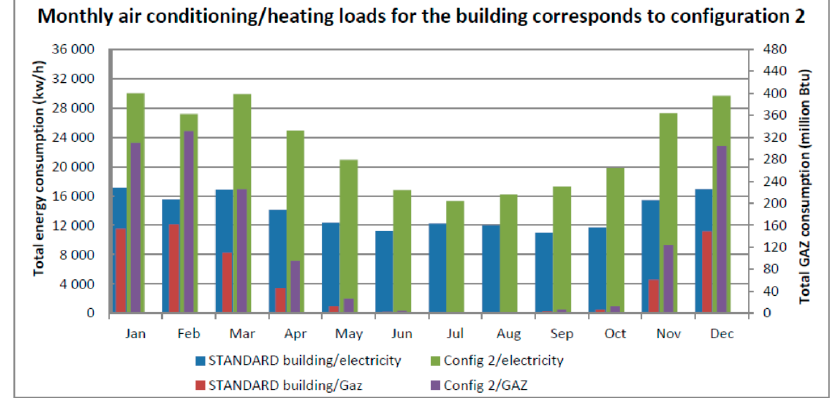
Figure 8. Monthly air conditioning/heating loads required to maintain the thermal comfort for configuration 2 compared to the loads required for the standard building.